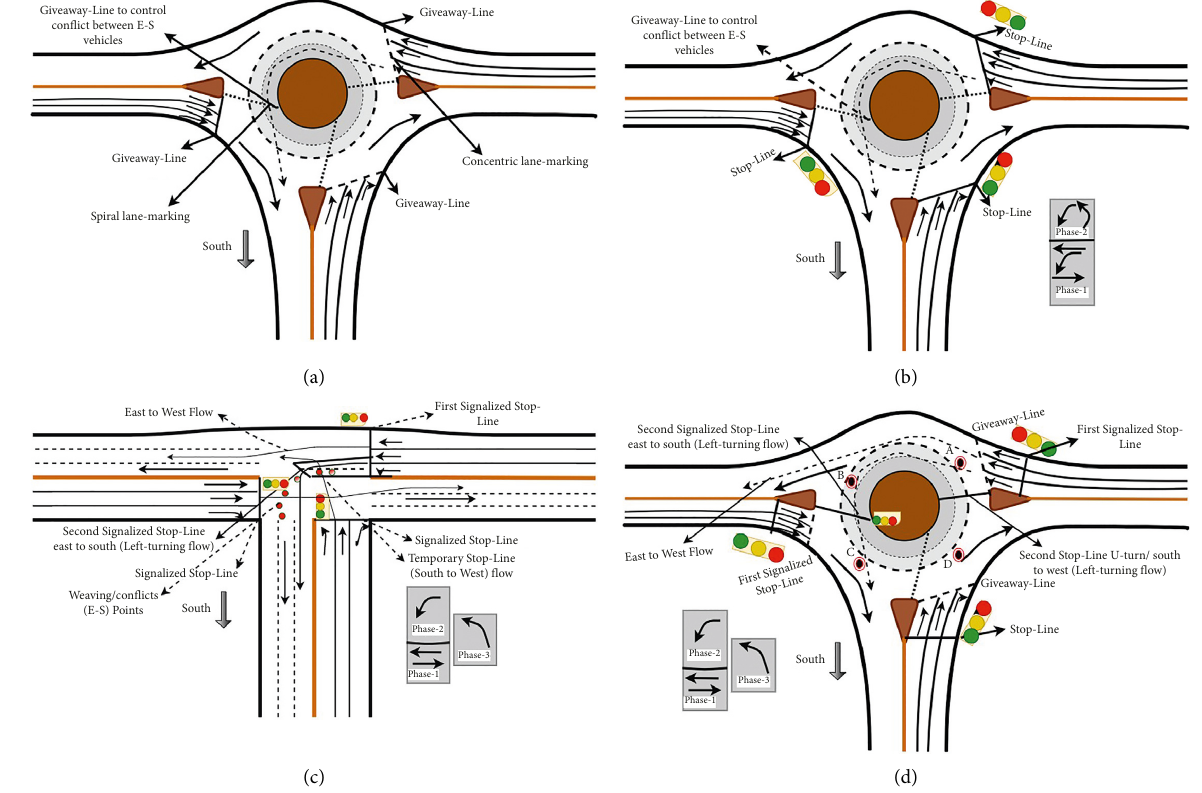
Figure 1: Geometry structure of roundabouts. (a) Modern roundabout. (b) Signalized roundabout. (c) Signalized intersection. (d) TLSR-